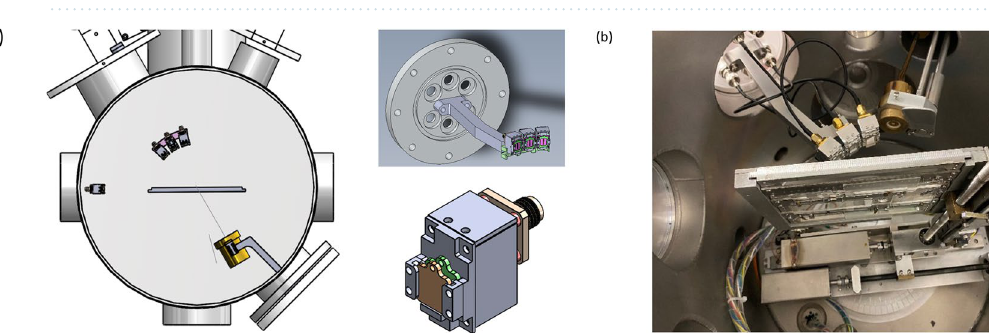
Figure 16. The benchmarking result at VDGT Lab in Tehran with measured VDGT data at 135° with different incident deuteron energies, ( a ) 1.9 MeV, ( b ) 1.8 MeV, ( c ) 1.7 MeV and ( d ) 1.6 MeV.